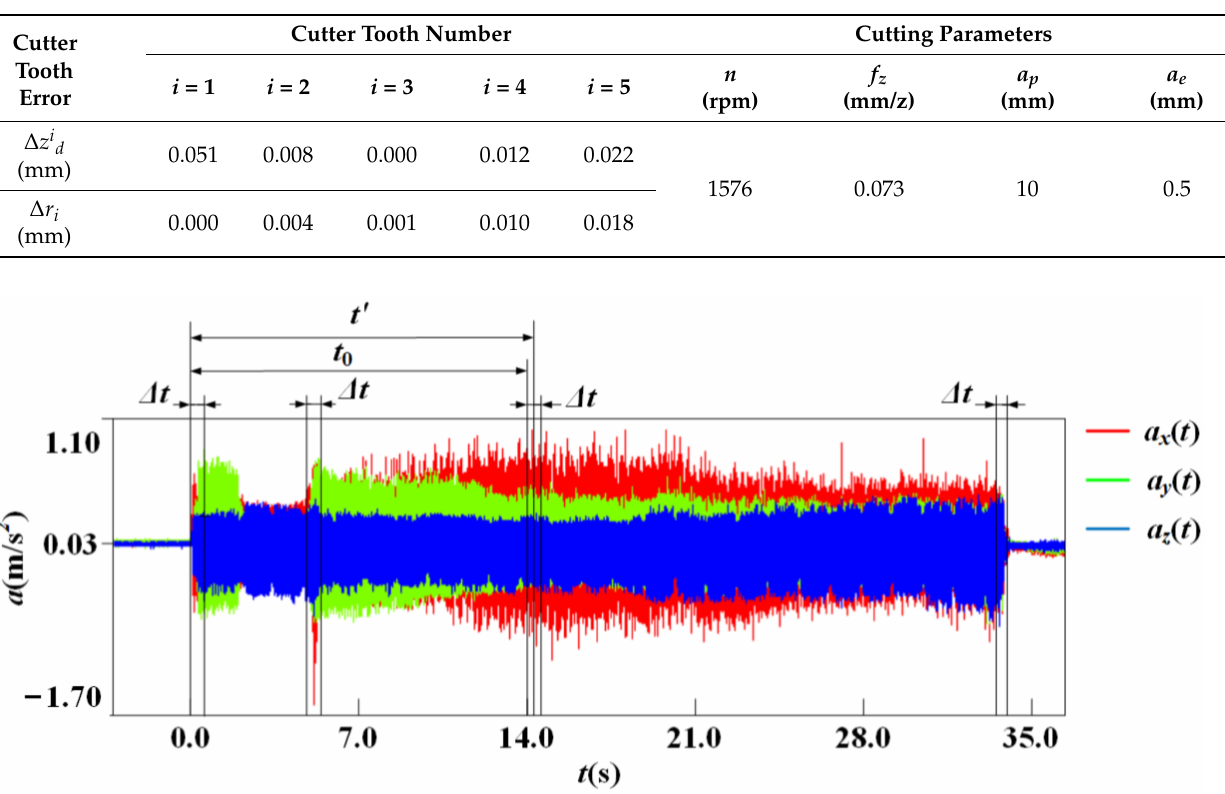
Figure 6. Milling vibration acceleration signal and selection of cutting